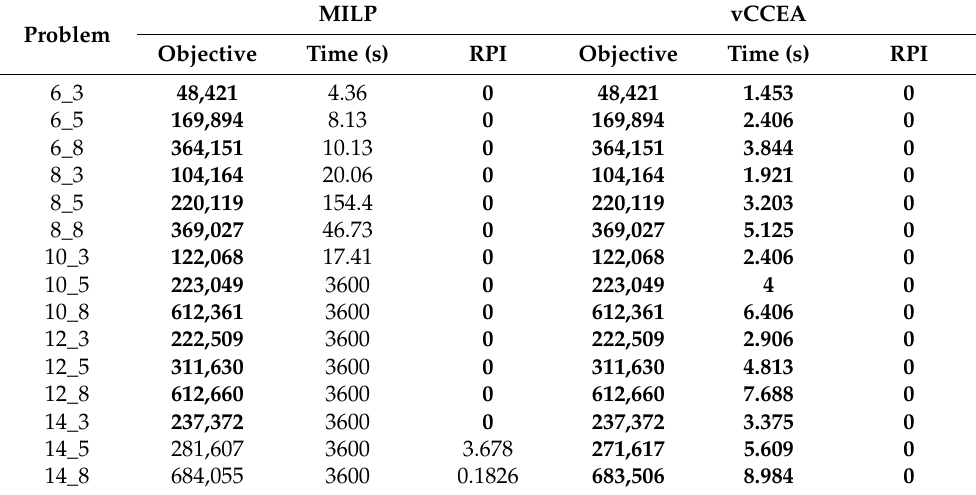
Table 6. The validation results of